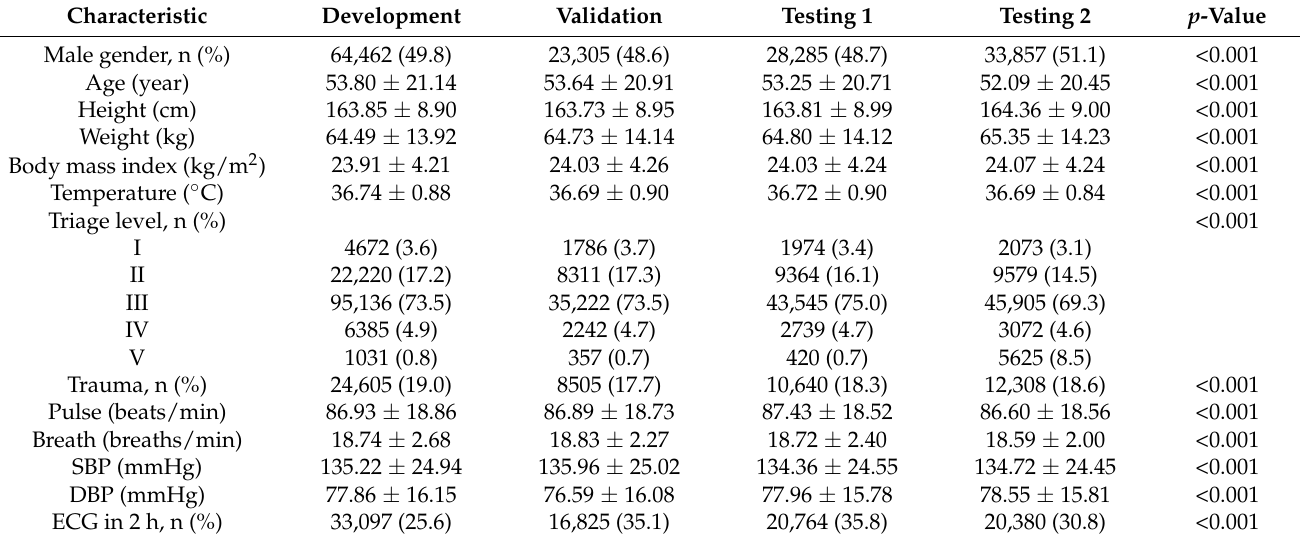
Table 1. Characteristics of development, validation, and testing cohorts.